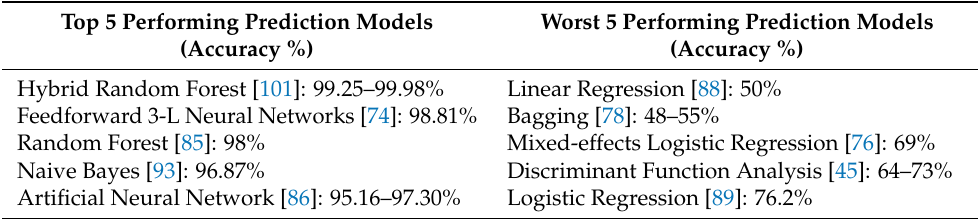
Table 9. Summary of top and worst prediction models based on the accuracy of predictions. Top 5 Performing Prediction Models